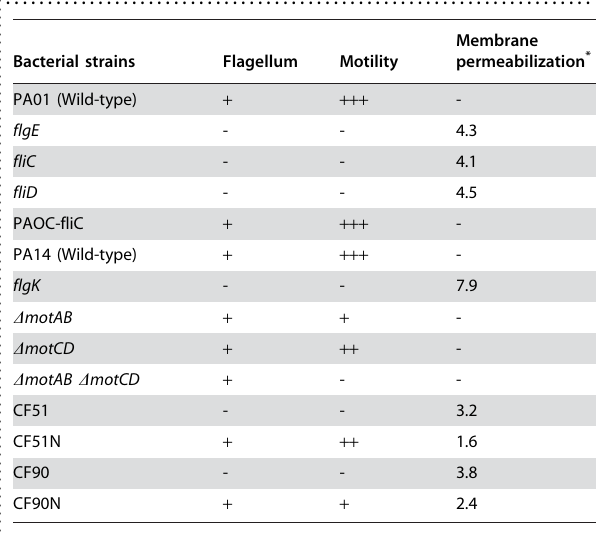
Table 2. Correlation of Flagellum Production, Motility and SP-